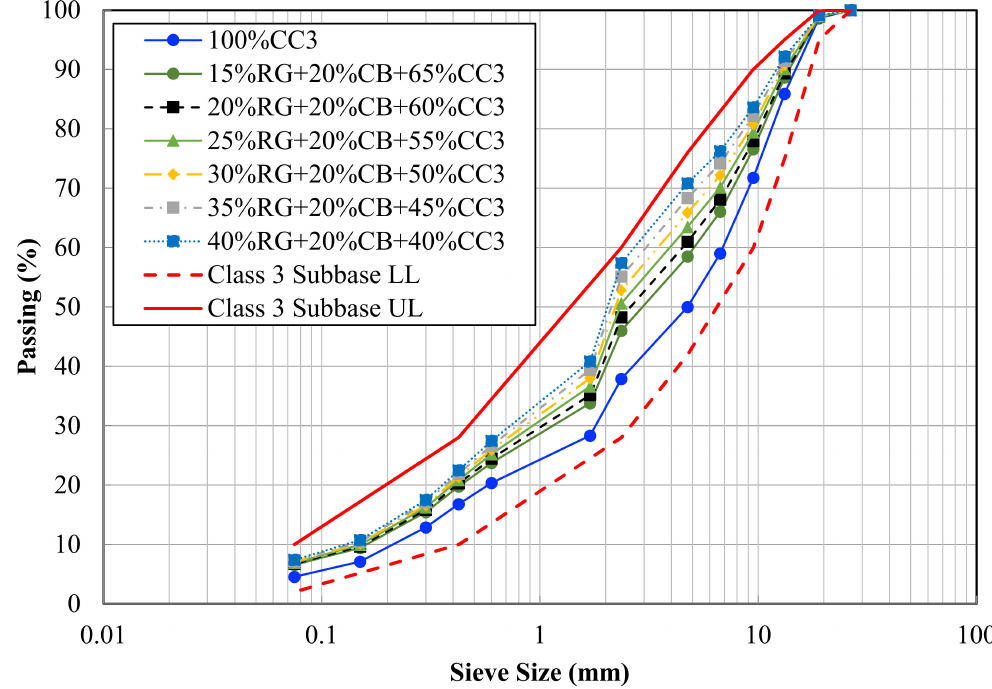
Figure 2. Particle size distribution of the nominated